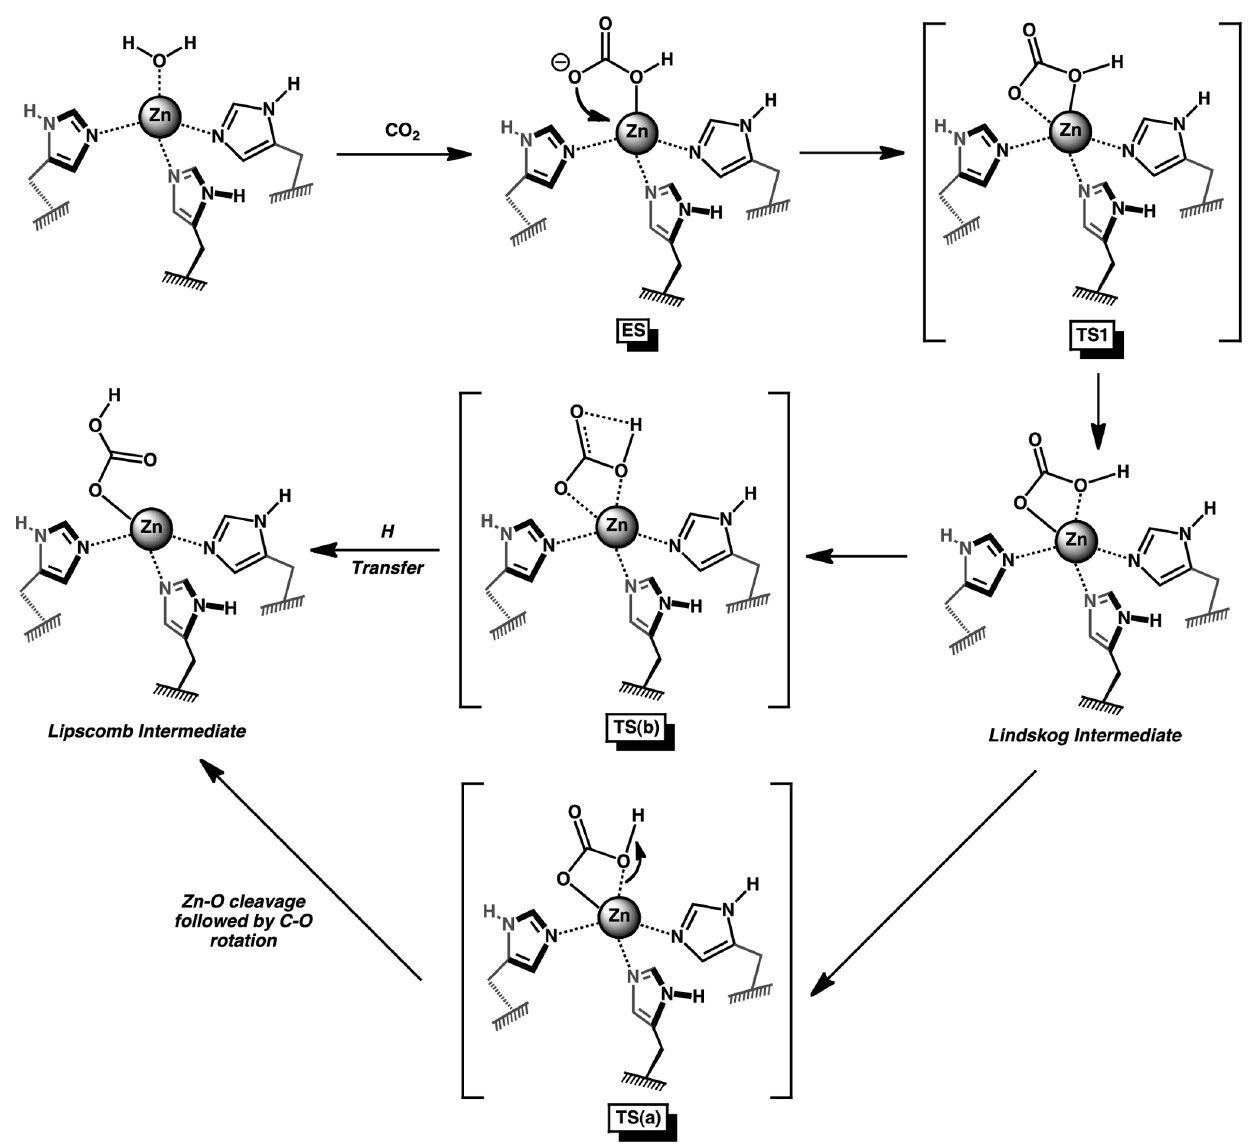
Figure 2. Schematic of the nucleophilic attack of CO 2 by the mimetics and the resulting geometries of the Lindskog and Lipscomb intermediates.